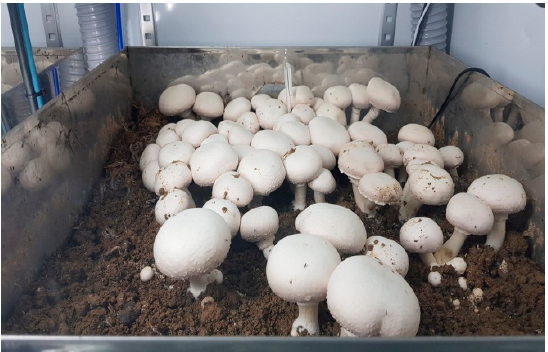
Figure 2. The small greenhouse for the experimental crops planted.